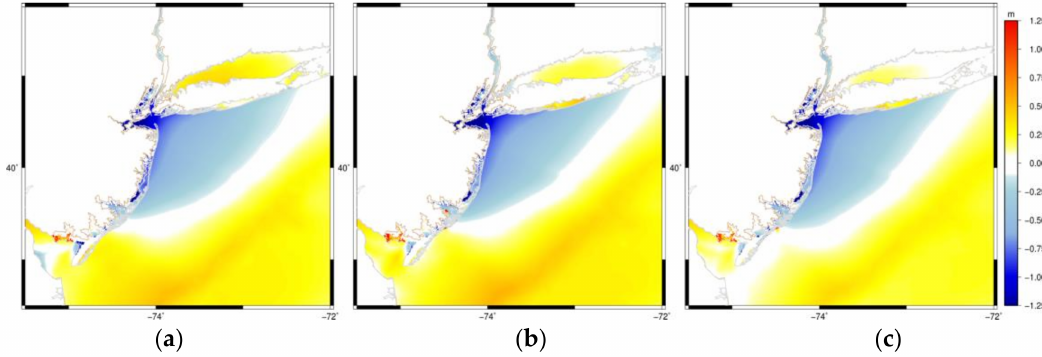
Figure 10. Differences from the control simulation for the ( a ) FWP12-4; ( b ) FWP12; and ( c ) FWP4